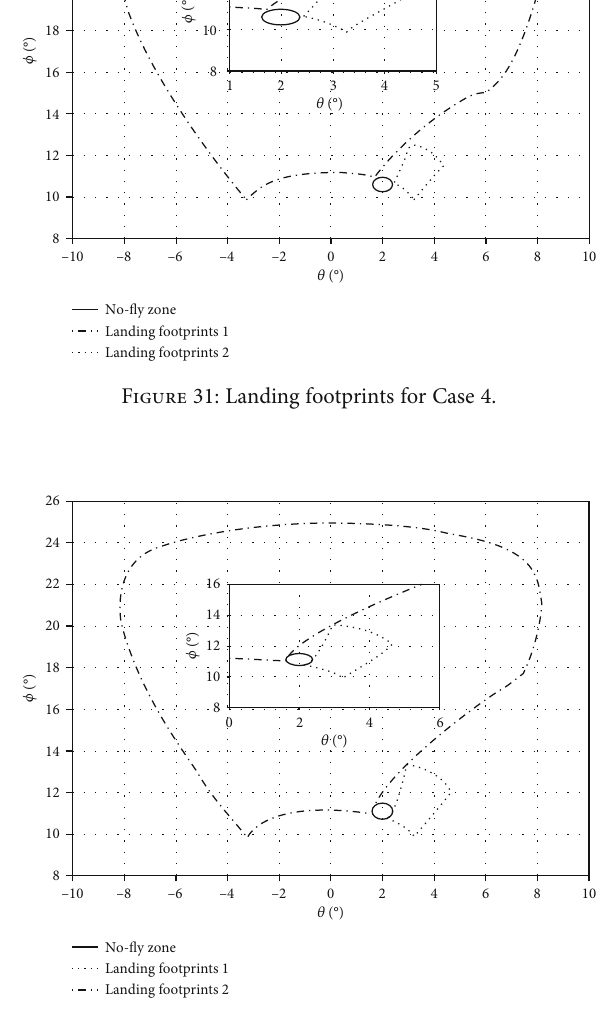
Figure 30: Landing footprints for Case 3.